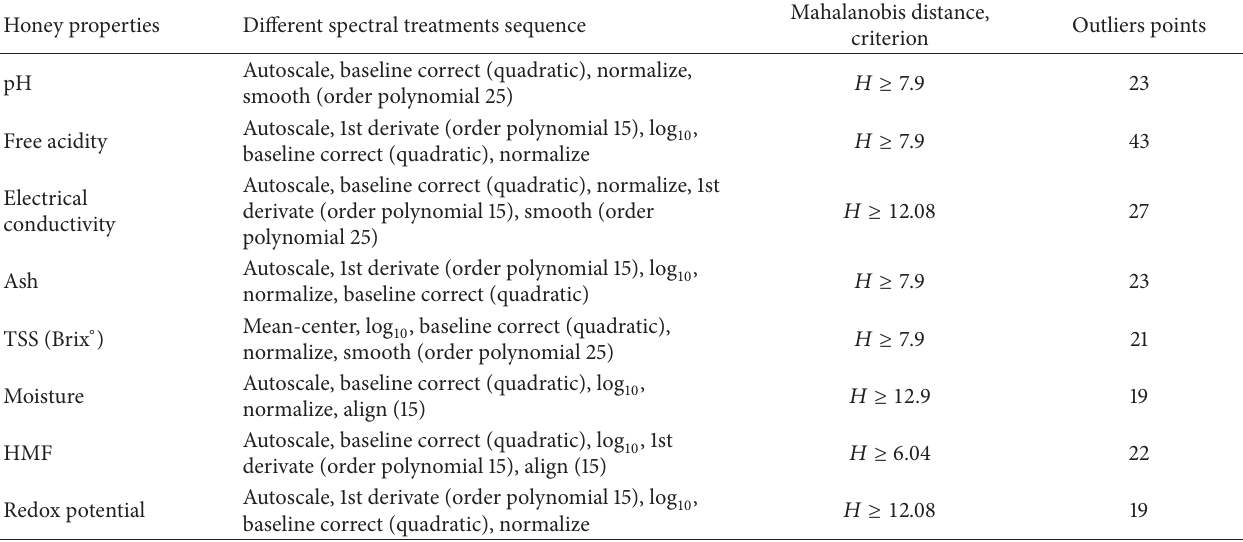
Table 1: PLS calibration models were developed applying different mathematics treatments to reduced errors in predicting of the properties of honeys.